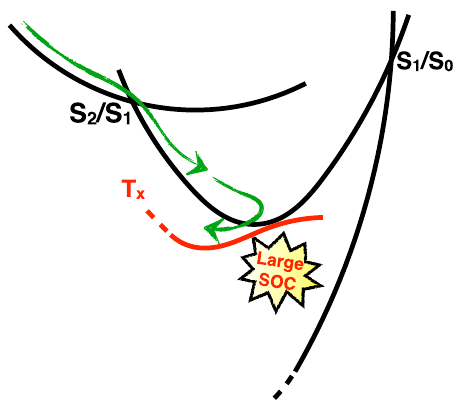
Figure 6. General scheme summarizing the preferred route towards the population of triplet states upon UVA excitation in thiated nucleobases.